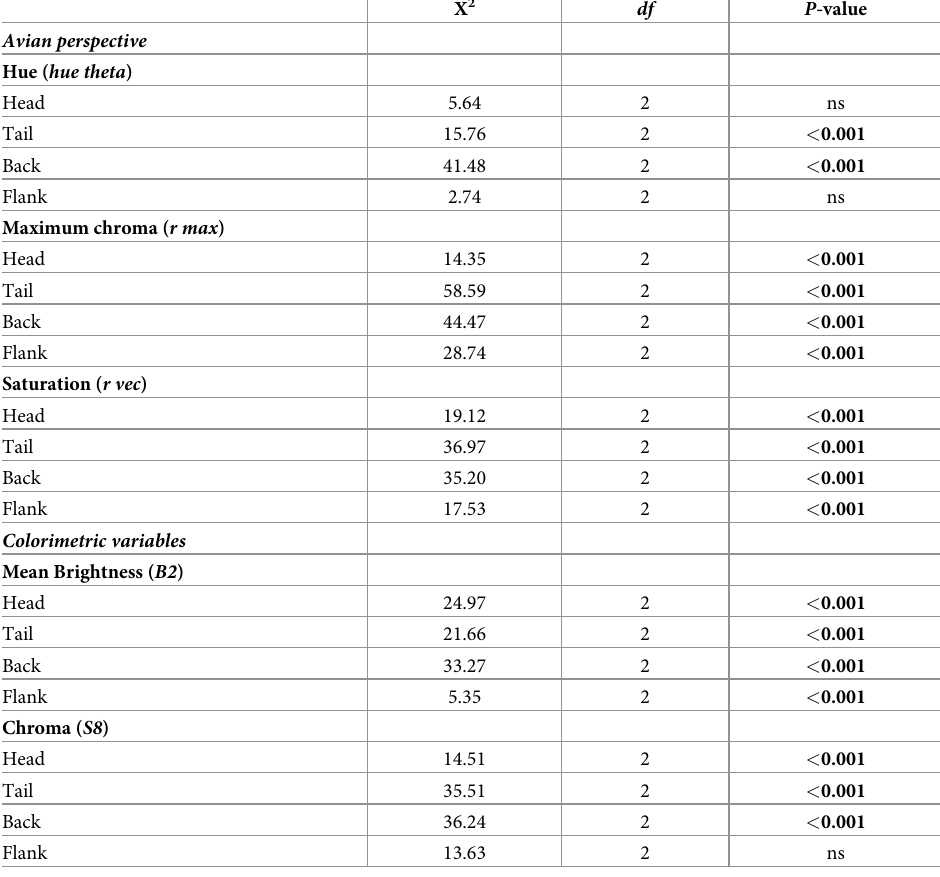
Significant comparisons are highlighted in bold after Bonferroni